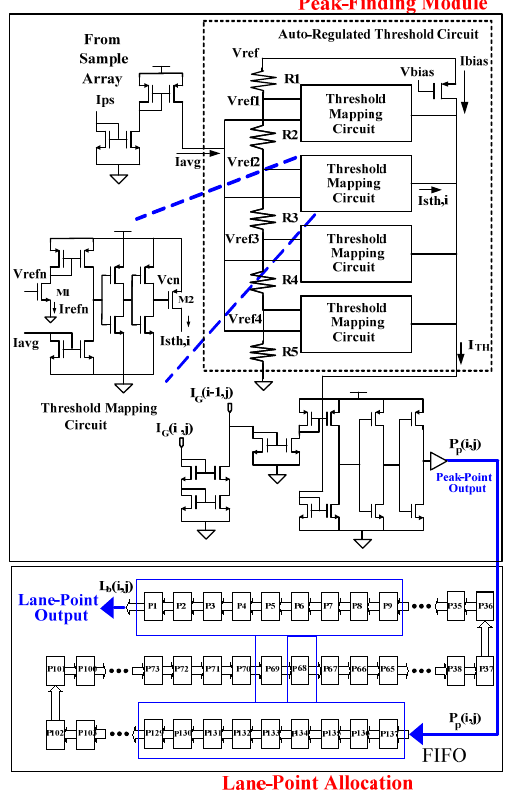
Figure 9. The Proposed Peak-Finding and Lane-Point Allocation